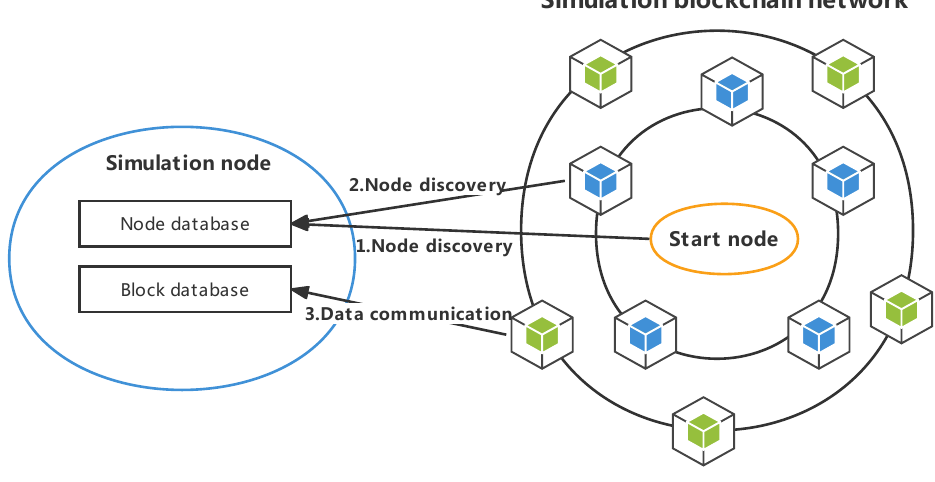
Figure 7. A node’s interaction with a peer-to-peer